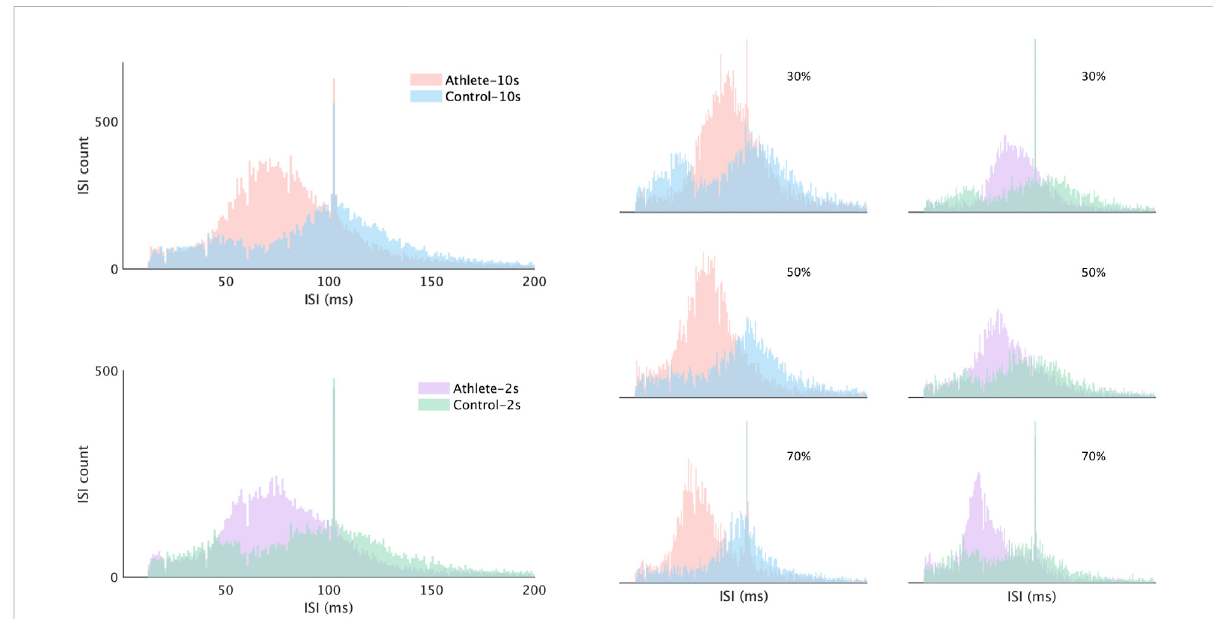
FIGURE 6 Distribution of MU interspike intervals. Histograms of MU interspike intervals are shown for the Athlete and Control group from each level and session. The interspike intervals were calculated from the entire contractions including ascending, plateau, and descending